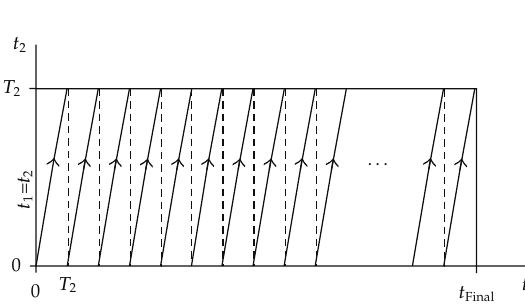
Figure 5: Sawtooth path in the t 1 t 2 plane, for recovering the univariate solution from its bivariate